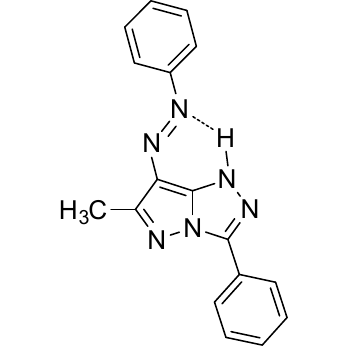
Figure 2. Formation of an intermolecular hydrogen bond in 1H-6-methyl-3-phenyl-7-phenylazopyrazolo[5,1-c][1,2,4] triazole